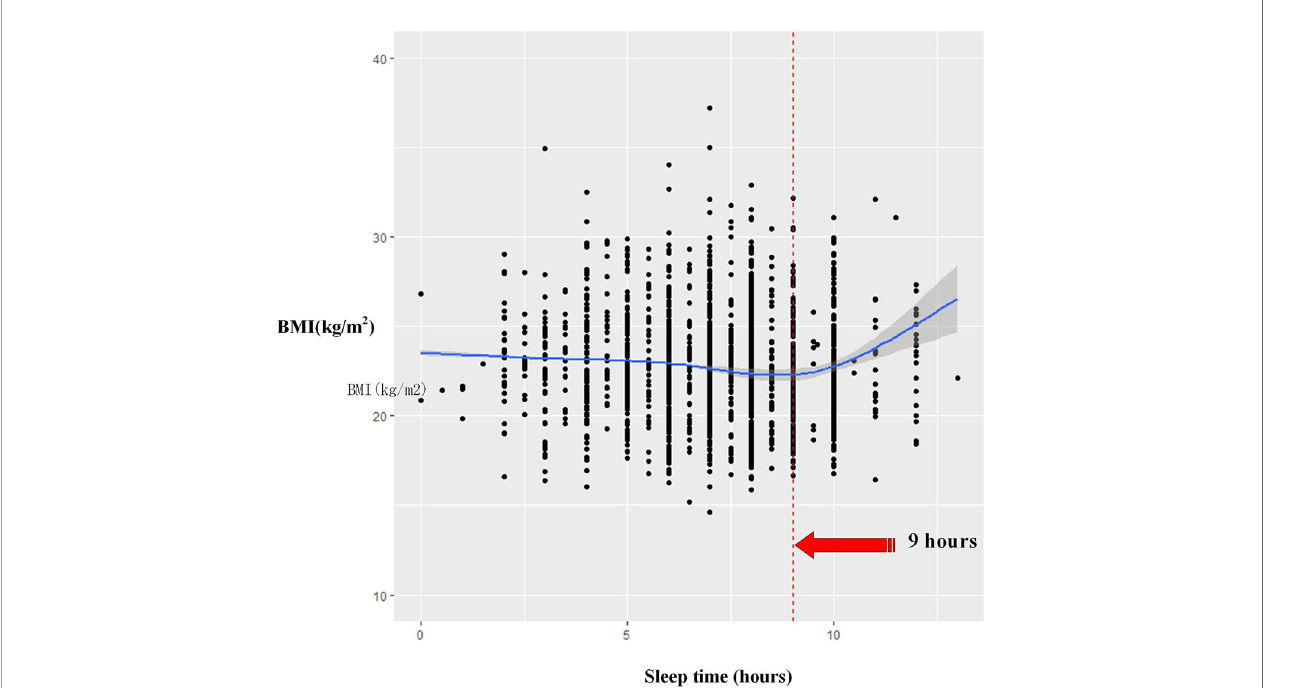
FIGURE 3 | The association between sleep duration and BMI among women using restricted cubic splines.